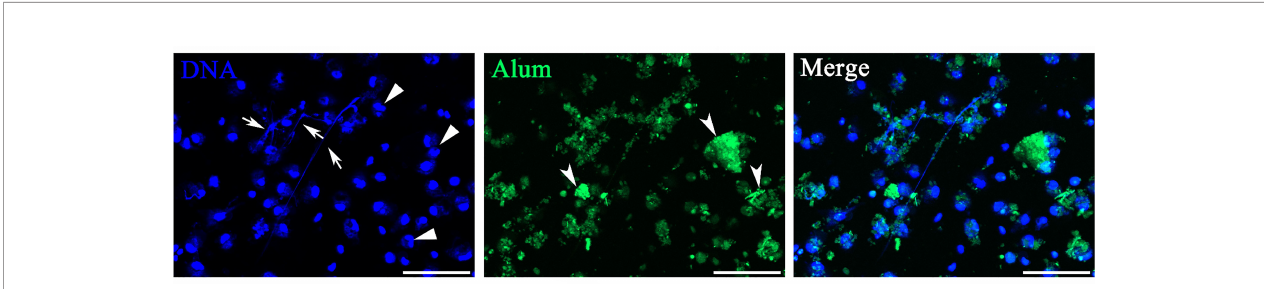
FIGURE 1 | Peritoneal cells stimulated with Alum led to attraction of neutrophils and extracellular trap formation in vitro . Fluorescence microscopy of peritoneal cells after stimulation with fl uorescently labeled Alum at 3 h illustrating the interaction of Alum particles with extracellular traps (ETs). Arrows with tail indicate ETs, triangles indicate neutrophils, and arrows without tail indicate patches of Alum particles. Scale bars, 20